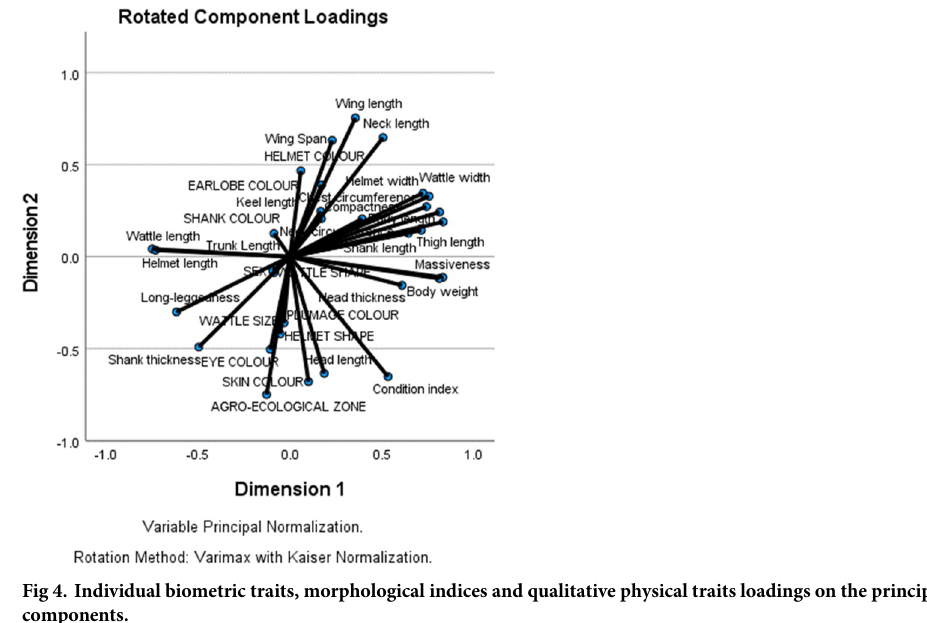
PLOS ONE | https://doi.org/10.1371/journal.pone.0261048 June 13,